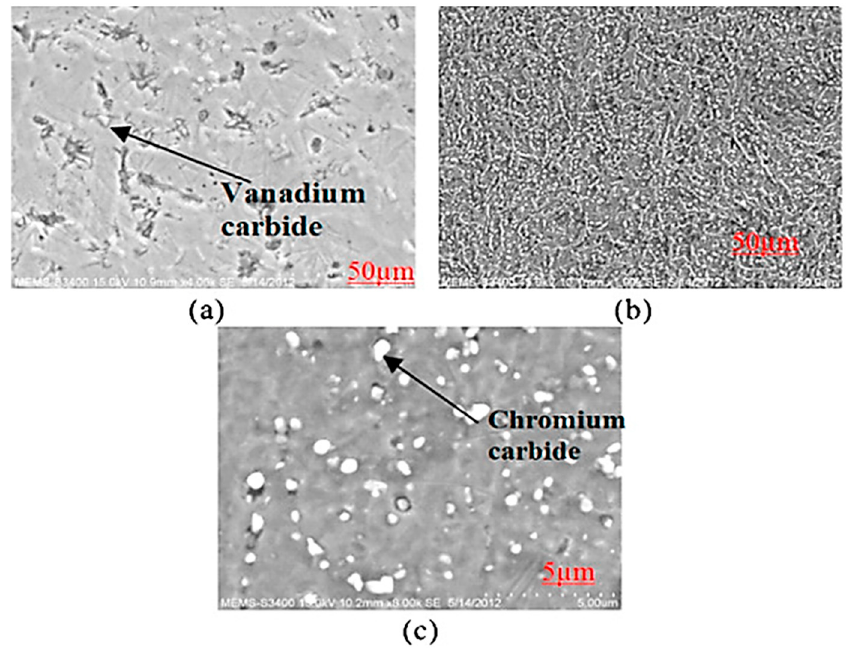
Figure 5. SEM images of CPM 9V: ( a ) deposition zone, ( b ) interface zone, ( c ) HAZ [78].